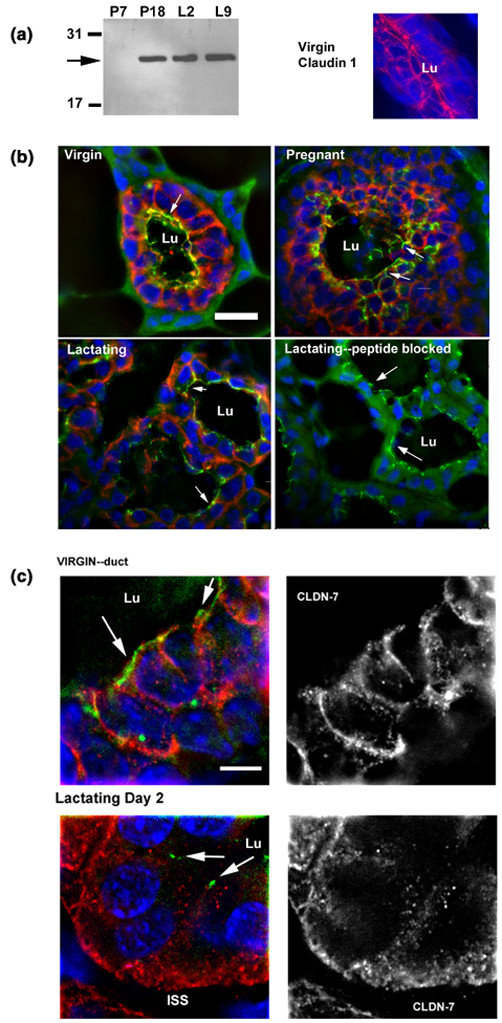
Claudin 7 immunohistochemistry in the mammary gland. (a) Western blot on 50 μg of protein from mammary gland at pregnancy days 7 and 18 (P7 and P18) and lactation days 2 and 9 (L2 and L9). Because gene expression is 20-fold lower at P7, as can be seen from Fig. 1a, protein would not be expected to be visible at this exposure. Right-hand side: section of gland from virgin mouse stained with antibody (Zymed) to Claudin 1. (b) Lower-power views of epithelial structures from the developmental stages indicated with fluorescein isothiocyanate-labeled ZO-1 (green), Cy3-labeled claudin 7 (red), and 4,6-diamidino-2-phenylindole-labeled nuclei (blue). Lu, lumen; adip, adipocyte. Lower right: anticlaudin antibody blocked with claudin 7 peptide. Scale bar, 30 μm. (c) High-power views of claudin 7 localization. The right-hand images show the merged views as in (b). The left-hand black-and-white images show only the claudin 7 stain, demonstrating clearly the punctate nature of the claudin 7 distribution near the basolateral membranes; claudin 7 is excluded from both nuclei and tight junctions. Scale bar, 10 μm. Arrows in all figures point to FITC-stained ZO-1 (green).